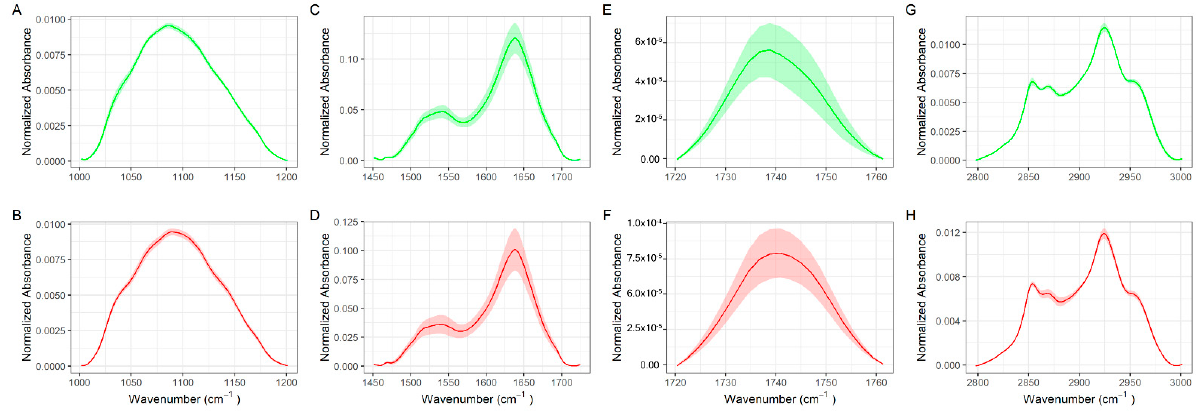
Figure 3. Enlarged details of characteristics absorption bands of biomolecules in EVs in control (green) and HCC patients (red), namely the carbohydrates and nucleic acids band at 1000–1200 cm − 1 ( A , B ), the amide I and II bands at 1470–1700 cm − 1 ( C , D ), the C=O stretching band at 1720–1740 cm − 1 ( E , F ), and the lipid CH stretching band at 2800–3000 cm − 1 ( G,H ). A box-plot analysis of the computed areas is reported in Figure 4 for the amide I and II bands at 1470–1700 cm − 1 (A), the lipid CH stretching band at 2800–3000 cm − 1 (B), the carbohydrates and nucleic acids band at 1000–1200 cm − 1 (C), and the C=O stretching peak at 1720–1740 cm − 1 (D). The result of a Wilcoxon rank–sum test for independent samples was superimposed on each plot. Data are summarized in Table 1. Statistically significant differences in the computed areas were detected for all the studied bands, with emphasis on the CH stretching band that displays a remarkably low p-value. Interestingly, highly significant differences are detected by computing the ratios between the CH-stretching band at 2800–3000 cm − 1 and the Amide I-II bands at 1470–1700 cm − 1 (Figure 4E), which is known as the spectral Lipid-to-Protein Ratio (LPR) [8,18], and provide a quantitative in- dex correlated to the relative amount of lipids and proteins in the analyzed samples. Re- markable differences are also observed in Figure 4F that reports the ratio between the CH- stretching band and the absorption peak at 1000–1200 cm − 1 , which can be defined—in analogy to Figure 4E—as the spectral Lipid-to-Nucleic acids Ratio (LNR). Taken together, Figure 4E,F hint at the occurrence of an alteration in the ratio between different molecular classes in EVs obtained from cancer patients compared to controls.